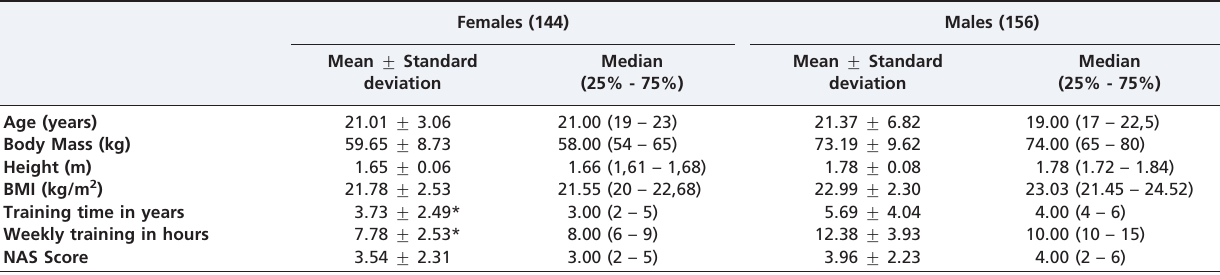
Table 1 - Descriptive analysis of the sample and training